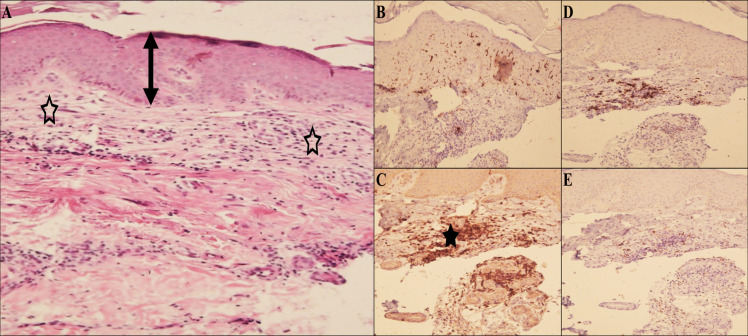
Histopathological and immunohistochemical findings in the treatment failure form.A) H & E staining shows histopathological changes of hyperkeratosis and acanthosis epidermis (double headed arrow) and dermis displaying histiocytic, lymphocytic and fibrohistiocytic cells infiltrate (empty stars), B) collection of Langerhans cells lattice in epidermis mostly, and dispersedly upper dermis by CD1a IHC staining, C) aggregation of histiocytes by CD68 IHC staining (star), D) lymphocytes infiltrate between histiocytes by CD3, E) rarity of positive B lymphocytes by CD20 IHC staining.